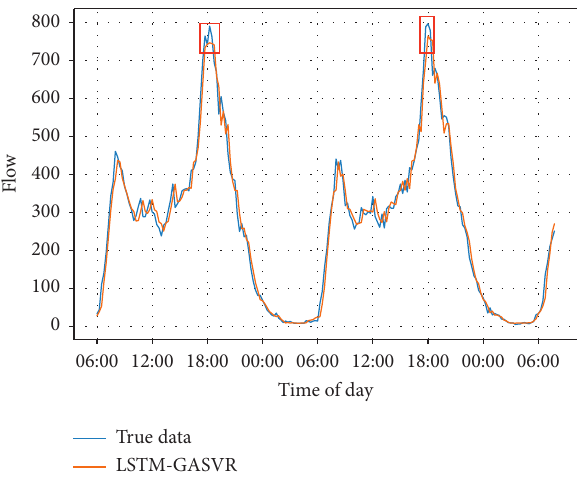
Figure 26: LSTM-GASVR prediction results.